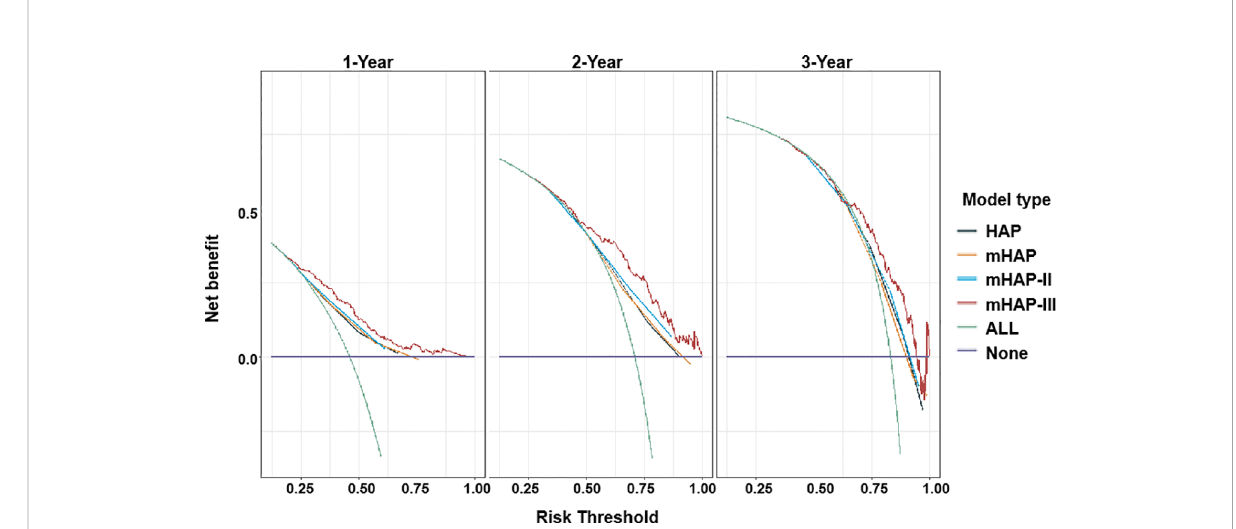
FIGURE 7 Decision curve analysis (DCA) for HAP series scores. Net bene fi t of using a model to predict 1-, 2-, and 3-year events of death as compared with strategies of “ assume high risk to all ” or “ assume low risk to all ” for different thresholds. HAP, hepatoma arterial-embolization